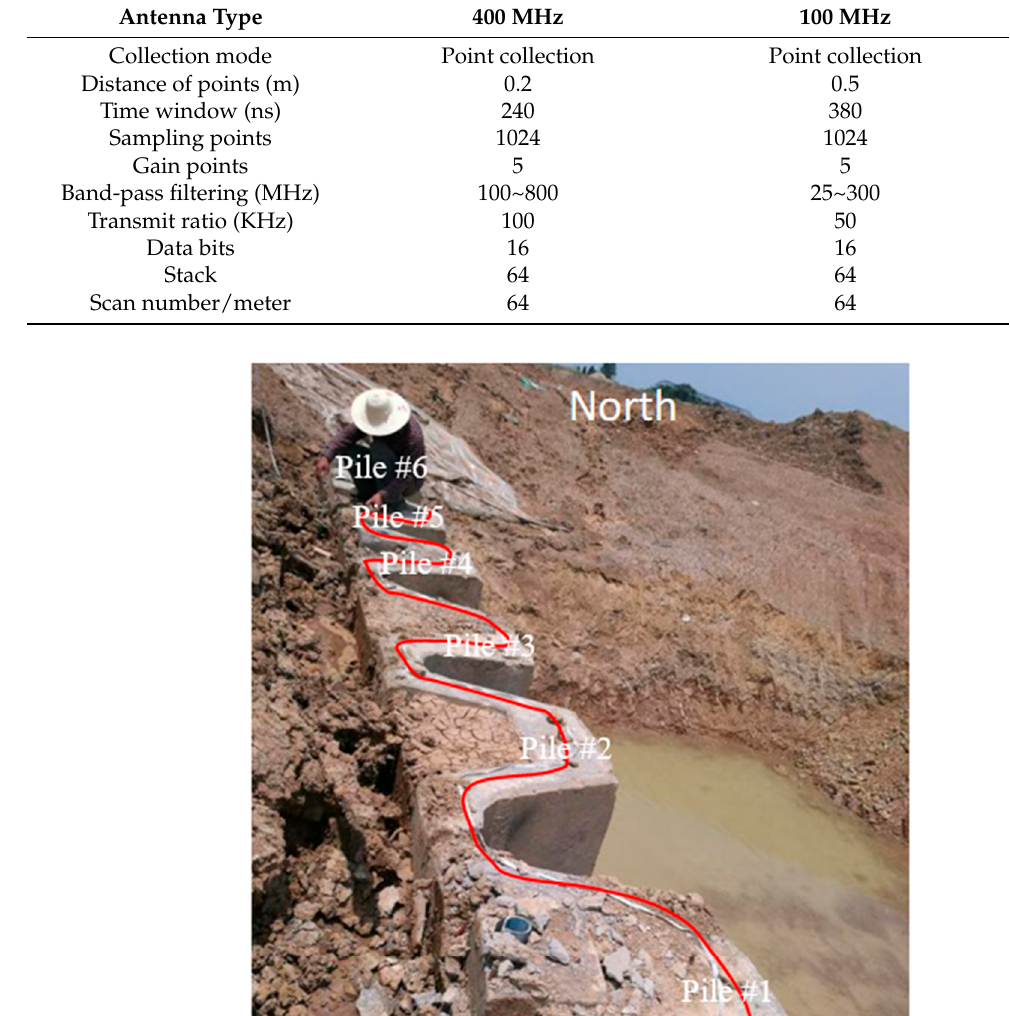
Table 1. Parameter settings for field data collection.